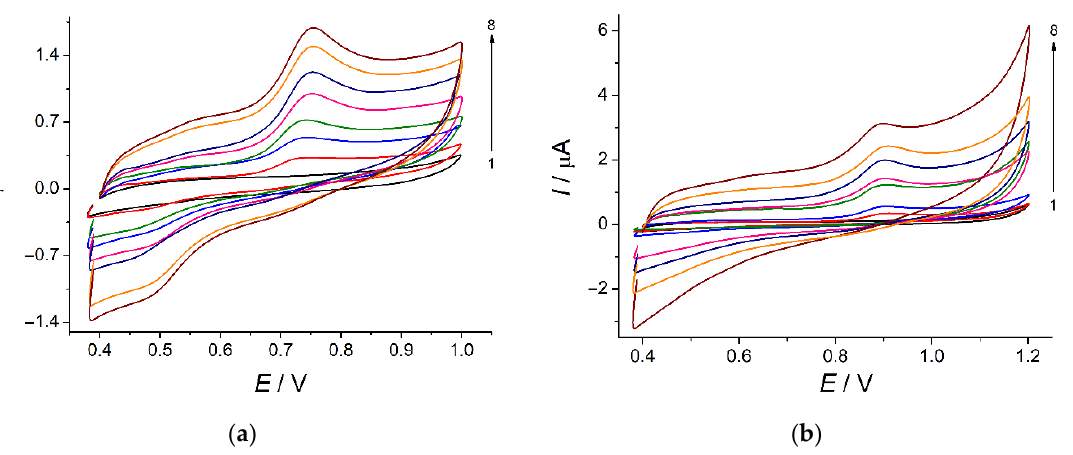
Figure 10. CVs of 10 µM ferulic acid ( a ) and vanillin ( b ) on polyBCP/f-SWCNTs/GCE in BRB, pH 2.0 (curve 1), at various potential scan rates (10 (curve 2), 25 (curve 3), 50 (curve 4), 75 (curve 5), 100 (curve 6), 125 (curve 7) and 150 (curve 8) mV s ‒ 1 ). Table 2. Effect of potential scan rate on the oxidation currents of ferulic acid and vanillin on polyBCP/f-SWCNTs/GCE in BRB, pH 2.0.